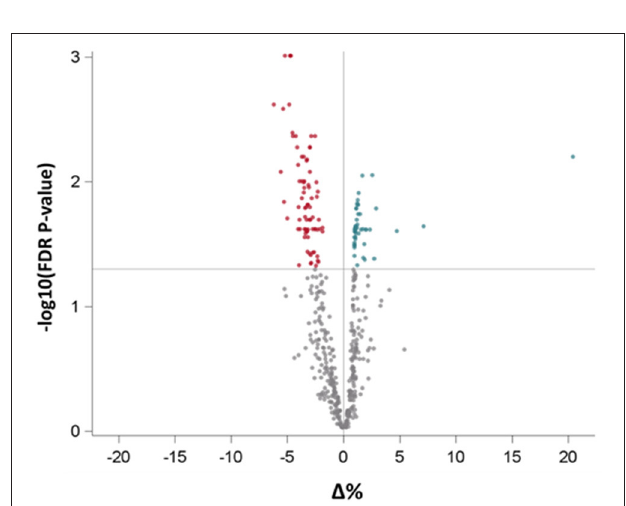
FIGURE 3 | Volcano plot reporting the association of BDNF levels with all measured miRNAs in extracellular vesicles. Red and green dots represent miRNAs, respectively, with negative and positive statistically significant association with BDNF. BDNF, Brain-Derived Neurotrophic Factor.